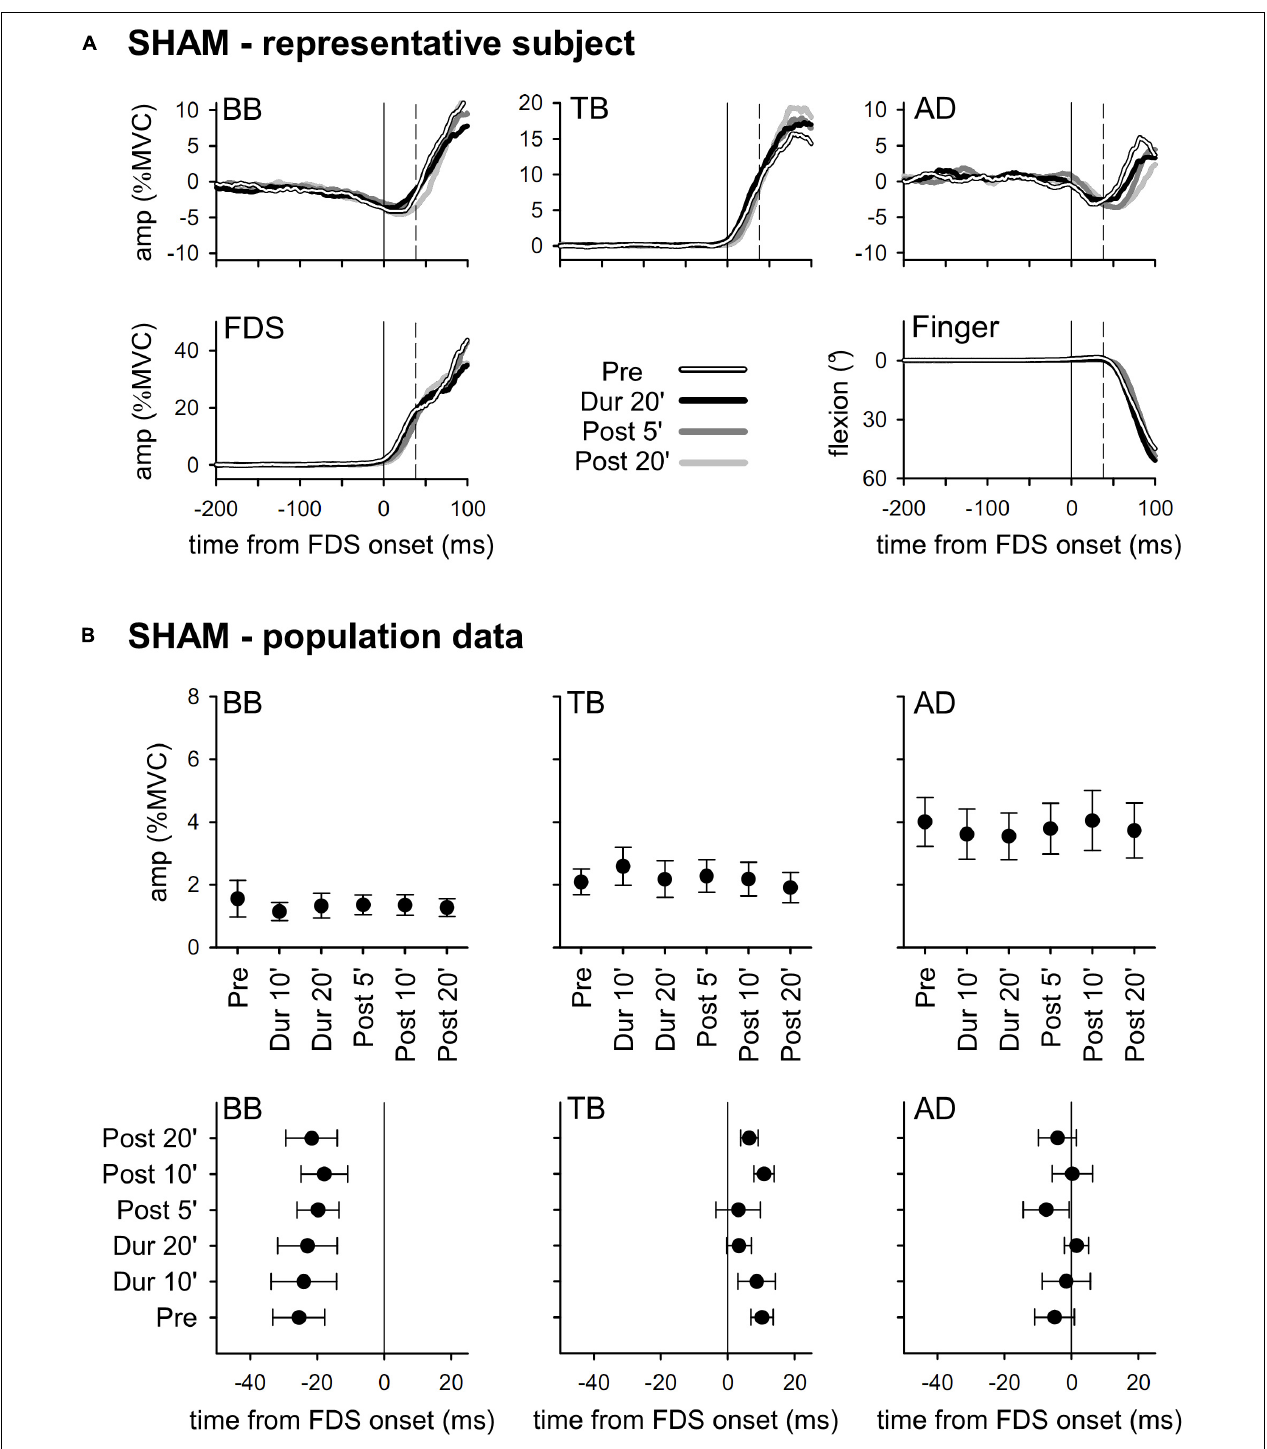
FIGURE 2 | In the (A) , rectified EMG and kinematics traces from a representative subject, who underwent SHAM tDCS (shades of black). Averages of 30 movement trials, recorded immediately before tDCS ( Pre ), in the last minutes of the “virtual” full-current period ( Dur 20’ ), and at 5 and 20 min after it ( Post 5’ and Post 20’ ). At all the time-points, the onset of activity (solid vertical line) in the prime mover Flexor Digitorum Superficialis (FDS) was accompanied by inhibitory APAs in Biceps Brachii (BB) and Anterior Deltoid (AD), and by an excitatory APA in Triceps Brachii (TB), which always preceded movement onset (dashed vertical line). Note how at each time point the traces are at all comparable, indicating that repeating the motor task had no effect on APAs, prime mover recruitment and focal movement kinematics. In the (B) , mean ( ± SE) amplitude and latencies of APAs recorded in the BB, TB and AD muscles of all subjects of the SHAM group. No significant changes occurred among the different time-points ( Pre vs. Dur 10’ vs. Dur 20’ vs. Post 5’ vs. Post 10’ vs. Post 20’ ), confirming the stability of APAs.